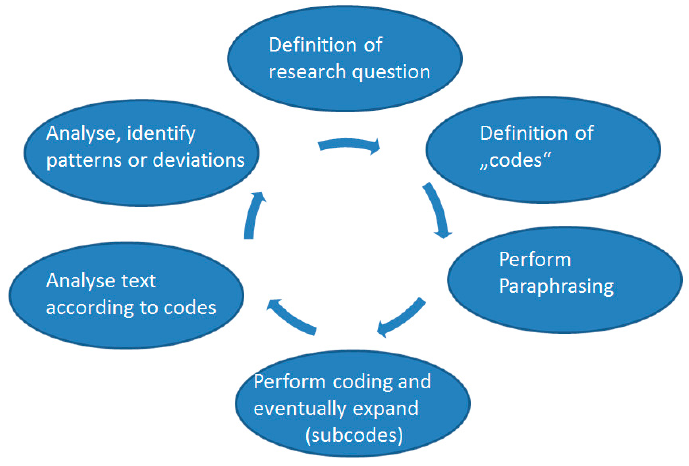
Figure 2. The method according to Mayring: Schematic presentation of the working steps. All qualitative analyses were performed using MAXQDA 2022 software (Ver- bi-Software, Berlin, Germany). Interview segments included in this article were trans- lated from German into English (and, where necessary, slightly adapted for easier read- ing).